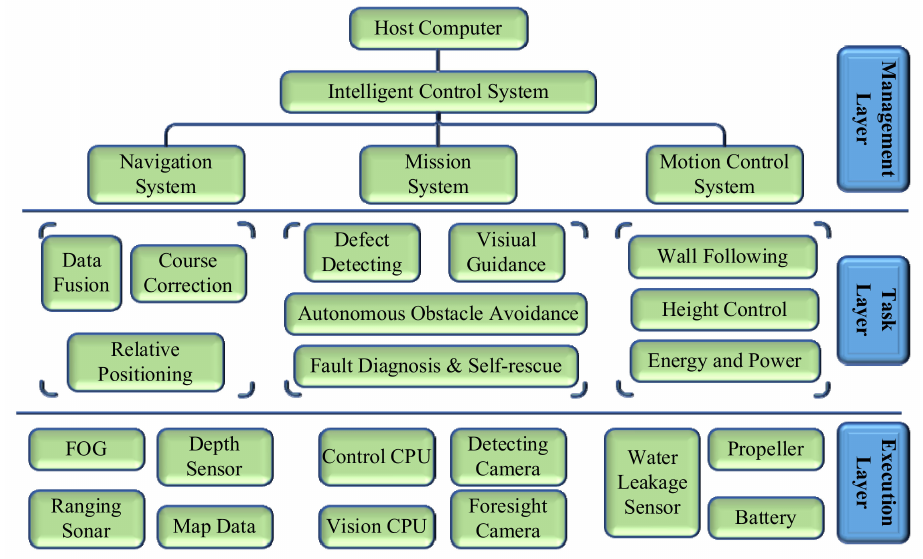
Figure 3. The layered